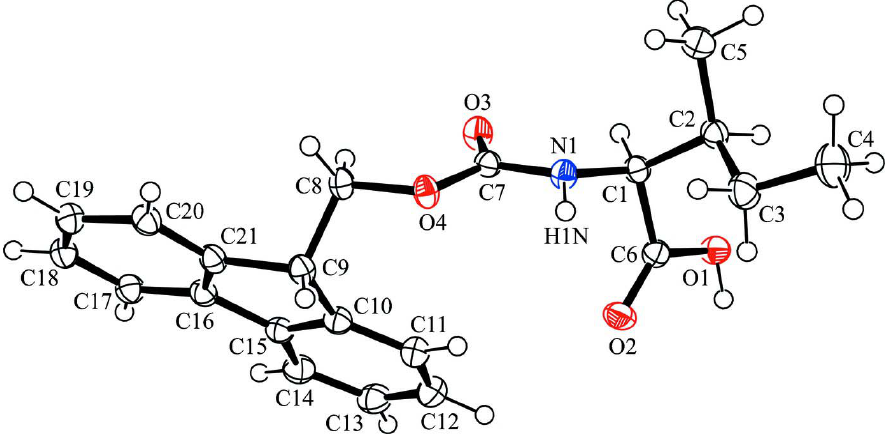
A view of the molecular structure of (I), showing the atom labeling scheme. Displacement ellipsoids are drawn at the 50% probability